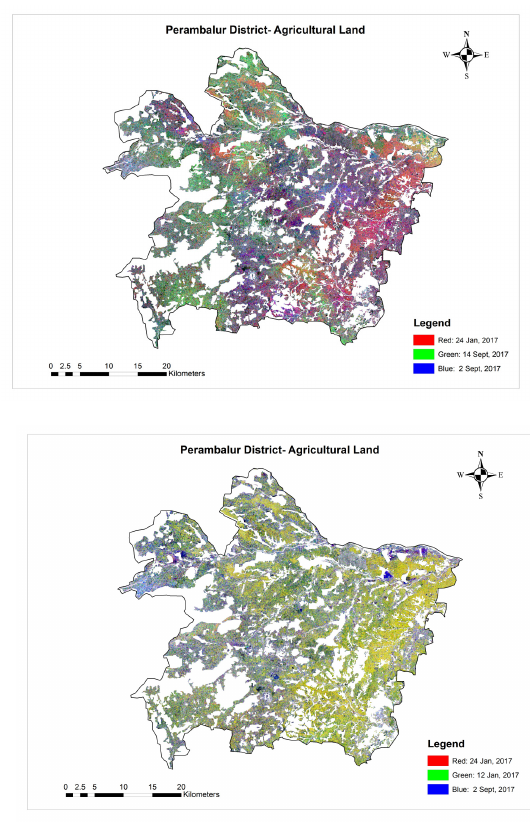
Figure 1: Multi-temporal Sentinel-1A data (a) VV polarization and (b) VH polarization Subset creation, orbital correction, border noise removal and terrain correction process was applied on to the image (figure- 2). Multi-temporal data was then layer stacked, VV and VH polarization bands were subjected to multi-temporal speckle filtering using Gama-map with a window size of 3 x 3. The intensity values of SAR images were converted to decibel (dB) using the linear to dB conversion tool and exported as geo-tiff for further